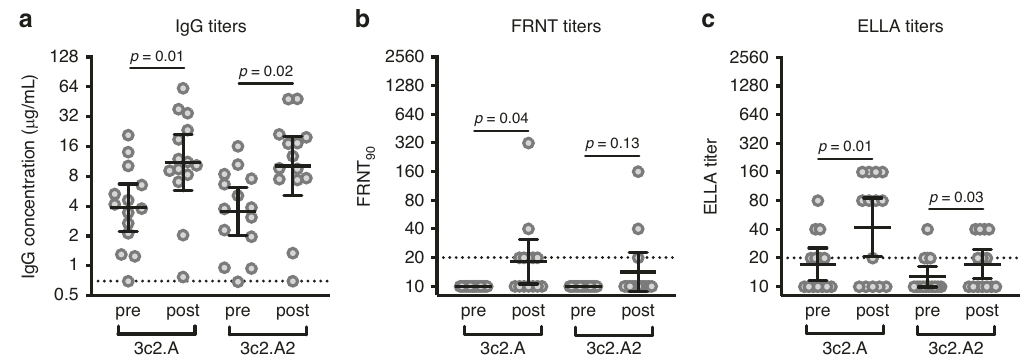
Fig. 2 Antibody responses before and after 3c2. A H3N2 infection during the 2014 – 2015 in fl uenza season. Serum samples were collected from adults ( n = 14 individuals) before and after laboratory-con fi rmed 3c2.A H3N2 infection and we quanti fi ed ( a ) HA IgG binding antibodies by ELISAs, ( b ) neutralizing antibodies by FRNTs, and ( c ) NA-speci fi c antibodies by ELLAs. Dashed lines represent the limit of detection for each assay. Lines represent the geometric mean titers with 95% con fi dence intervals. Two-sided paired t tests were completed on log 2 -transformed data, and p values are indicated.